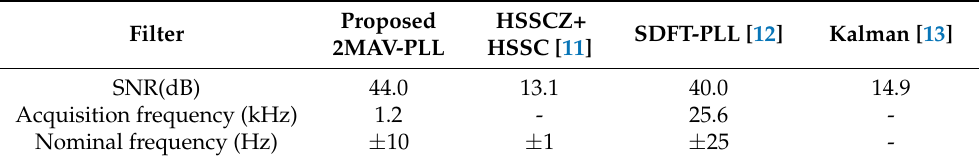
Figure 20. Original and filtered ECG signals. Table 4. Comparison among filtering